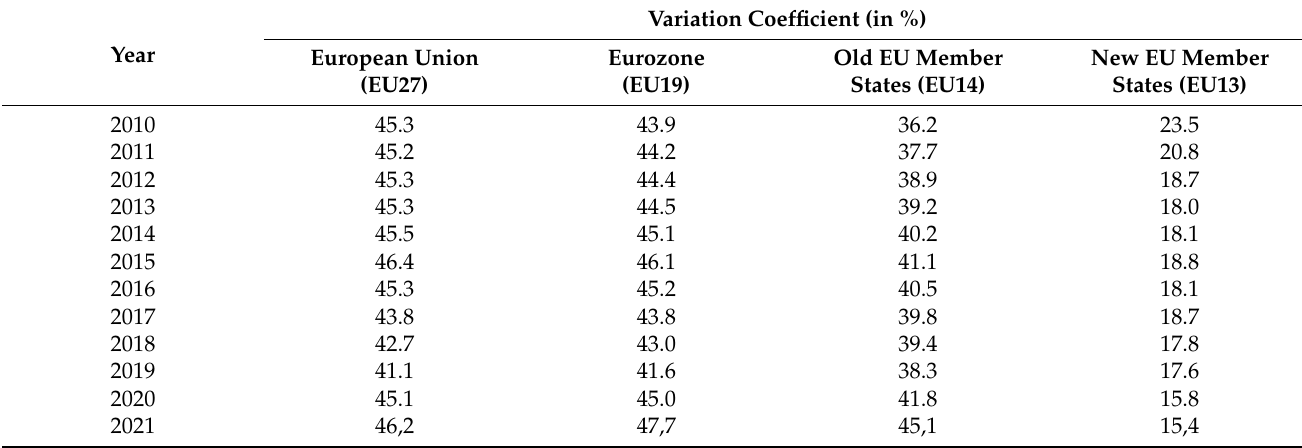
Table 2. Variation coefficient of per capita GDP in PPP